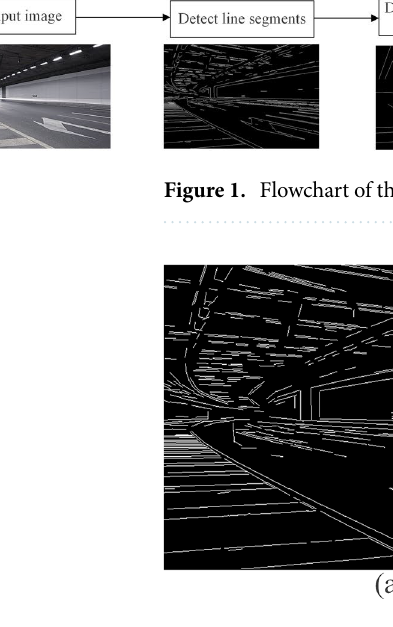
Figure 2. Filter feature line